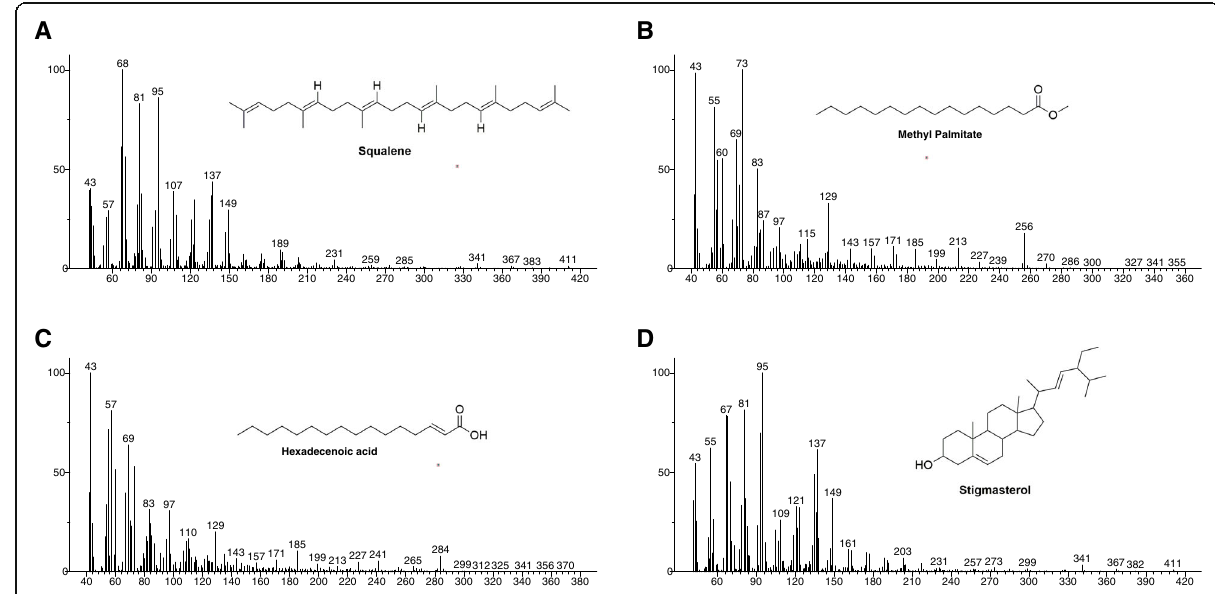
Fig. 3 Mass spectrum of identified